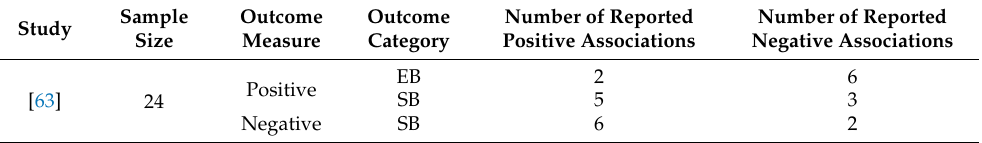
Table 10. Video game play—outcome measure descriptions and results